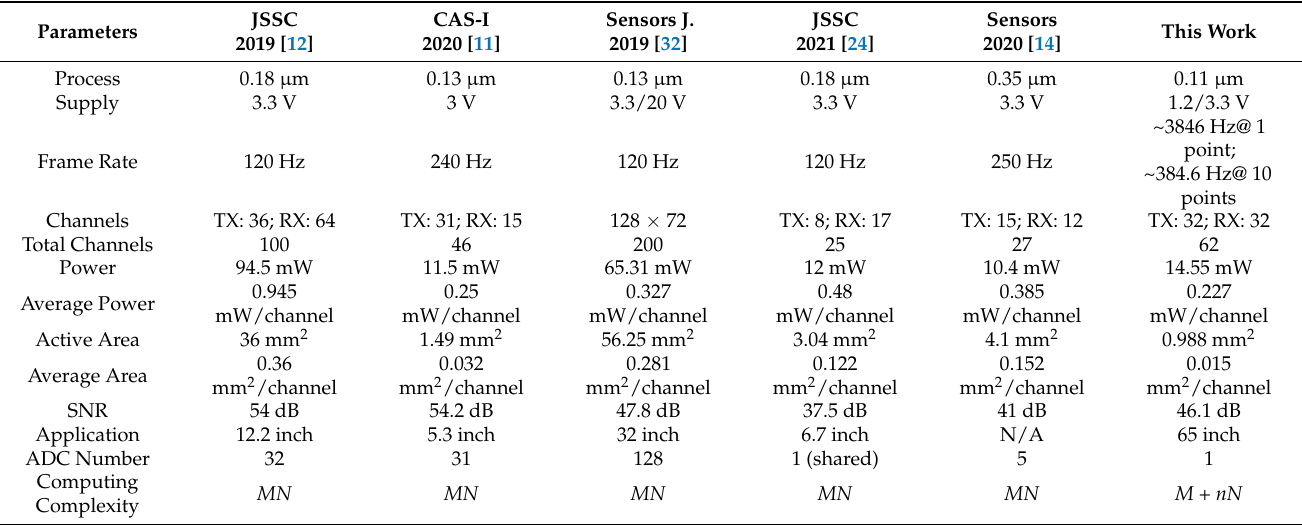
Table 1. Performance